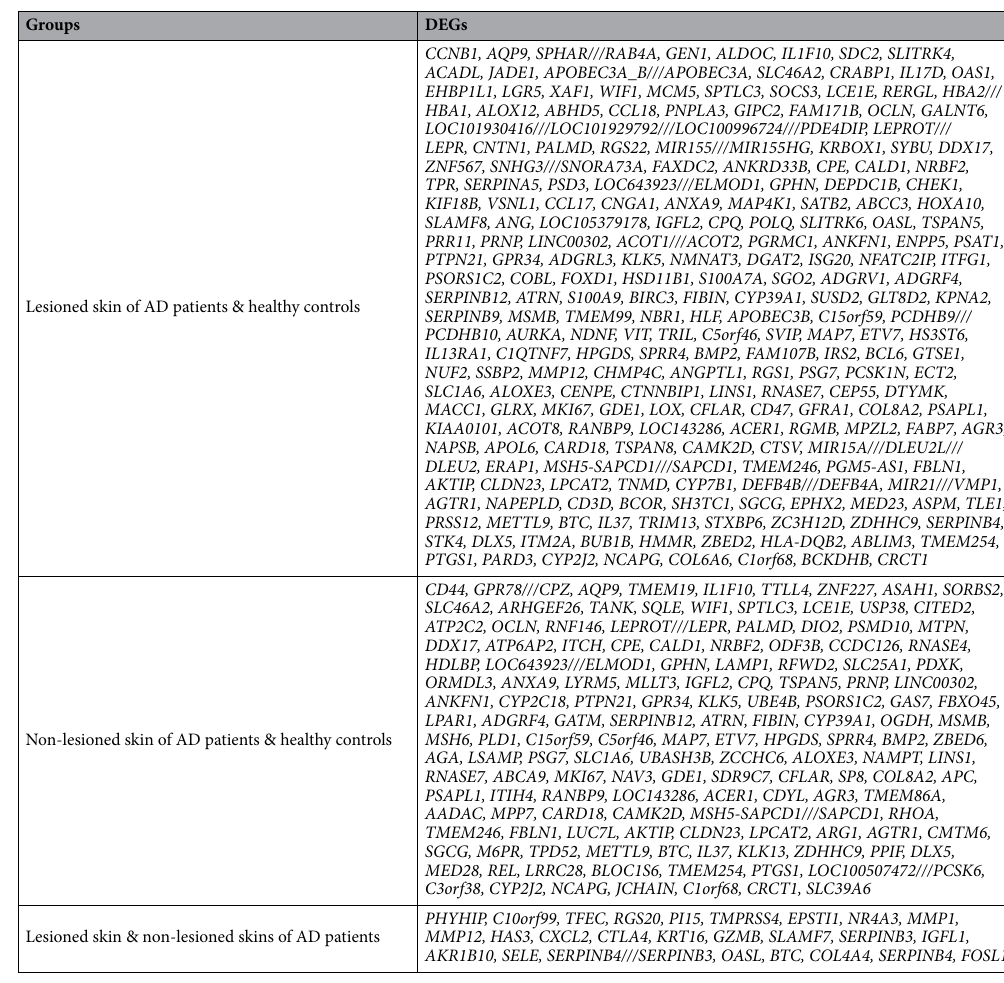
Table 1. DEGs between AD patients and healthy